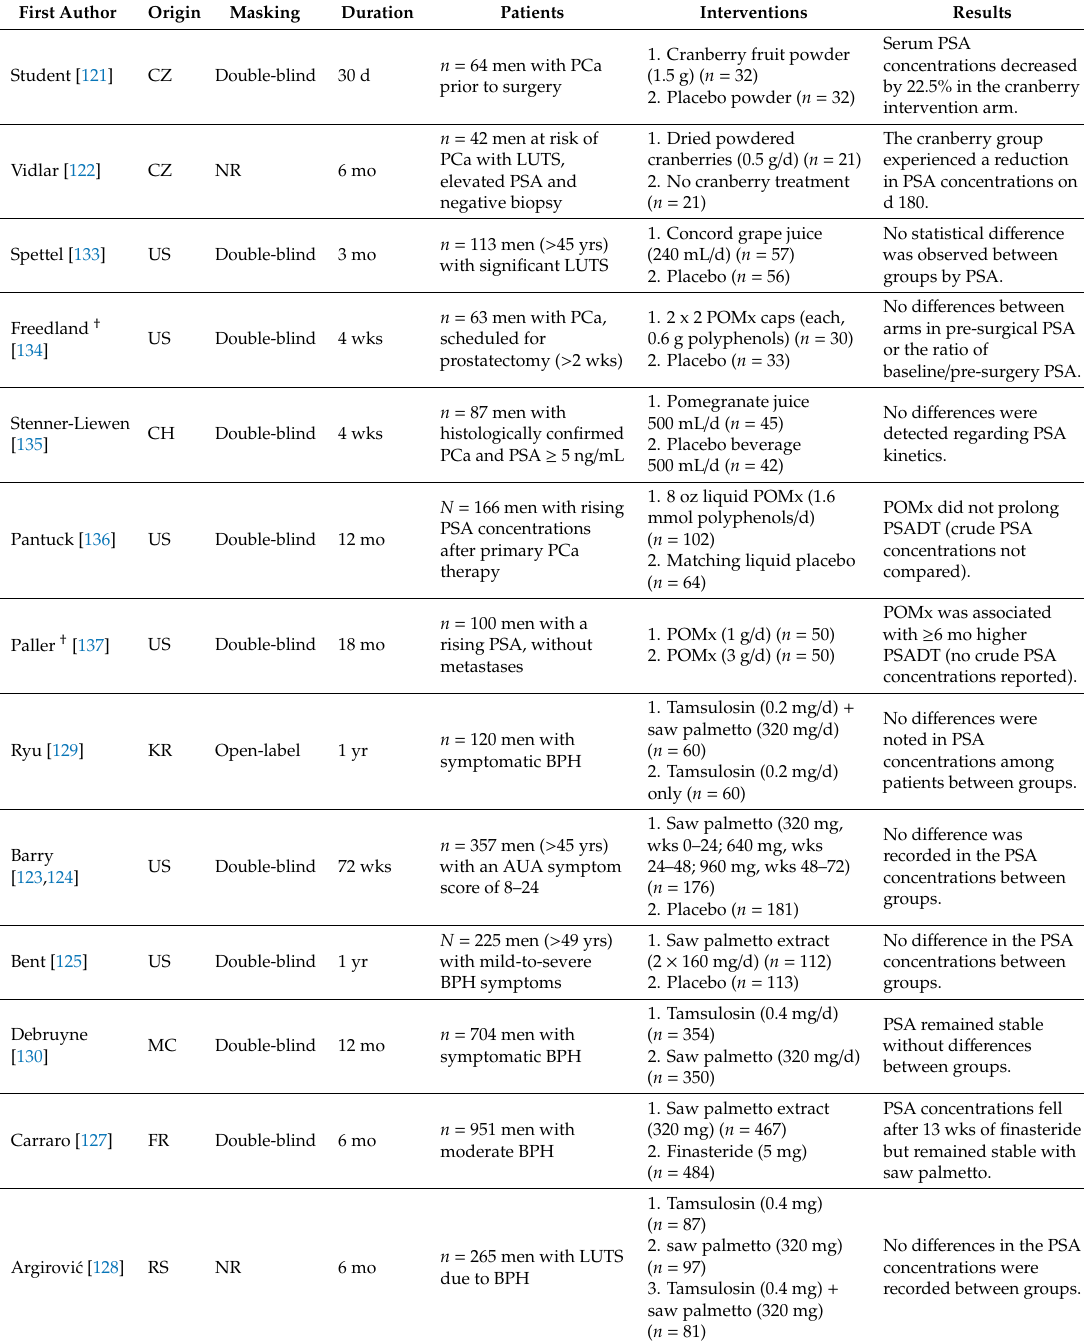
Table 6. RCTs examining the e ff ect of fruit and fruit extract supplementation on PSA concentrations among men with PCa, increased PCa risk, or